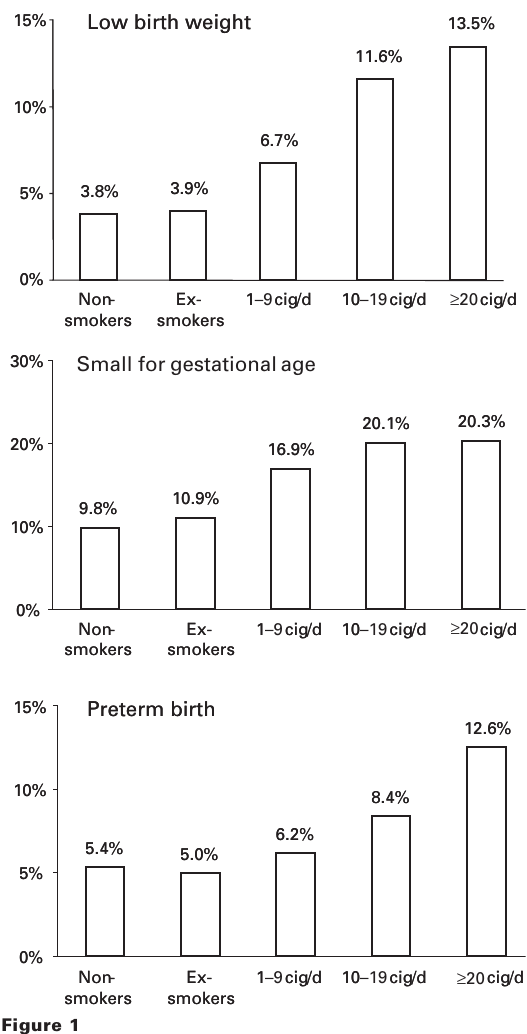
Proportions of infants with low birth weight, small weight for gestational age or born prematurely across categories of maternal